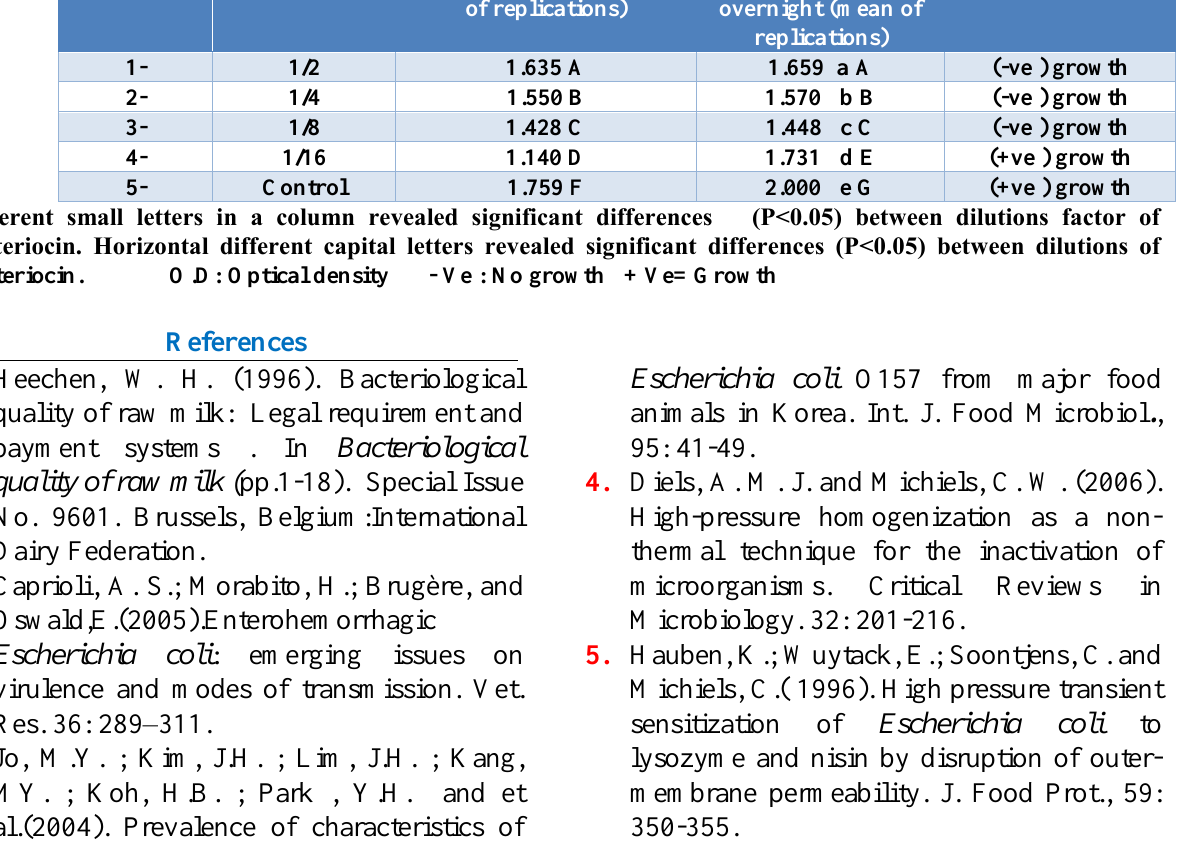
Table, 6: Turbidmetric assay for minimum inhibition concentration of the bacteriocin by using spectrophotometer